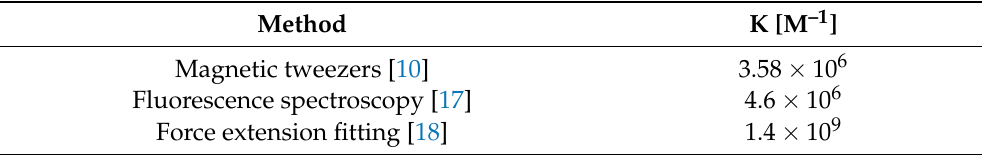
Table 1. Literature values of equilibrium constant for bis-intercalation DNA-YOYO-1 complex formation determined by different